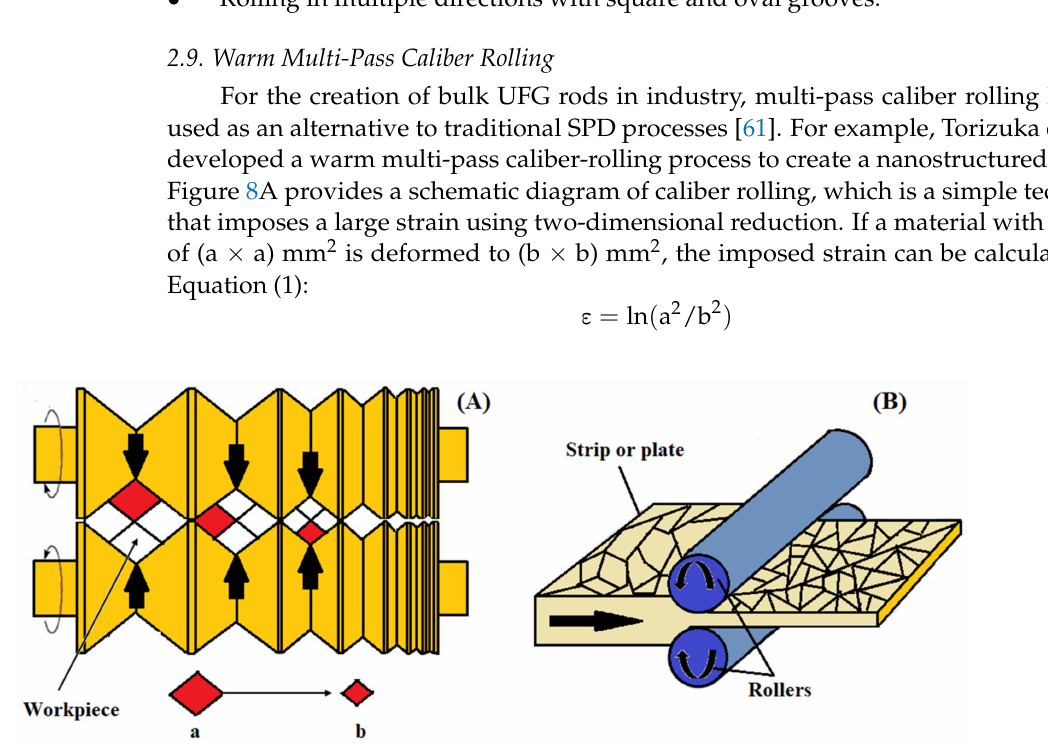
Figure 8. Schematic drawing of caliber rolling ( A ); reproduced from [60], with permission from Elsevier, 2020. A schematic diagram of the cold-rolling system ( B